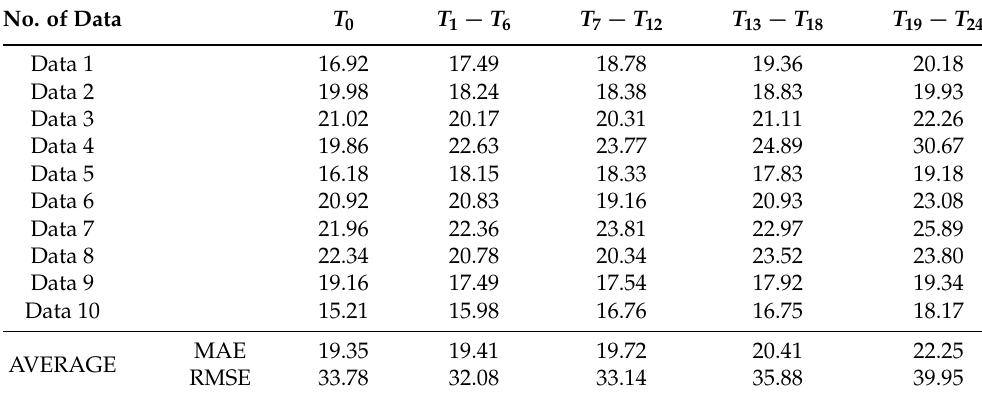
Table 6. The detailed results of our proposed model with weighted summation for all 10 times. The values in the table are the MAE of AQI